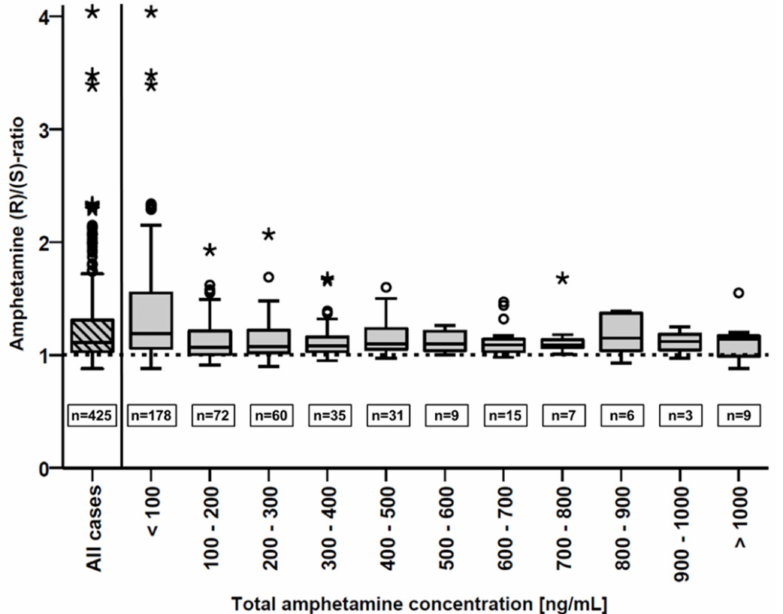
Figure 3. Boxplots of the determined amphetamine (R)/(S) ratios within subgroups of total am- phetamine concentration. The striped left box represents the whole sample collective (n = 425). Horizontal lines represent the median, boxes represent the range between the lower and upper quartiles of the subgroups (interquartile range). Whiskers represent all samples within ± 1.5 times the interquartile range. Outliers with (R)/(S) ratios greater than median ± 1.5 times the interquar- tile range are presented as circles (o). Extreme values with deviations greater than ± 3 times the interquartile range are presented as asterisks